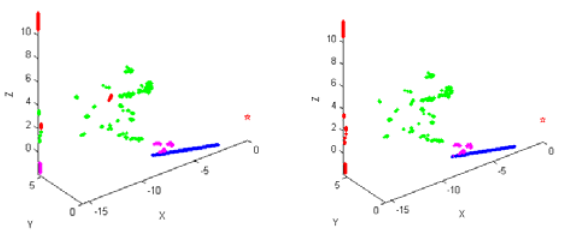
Figure 4. Classification result of the representative scan line obtained from GMM-EM (left) and CRF (right); Red: Vertical objects; Blue: Ground; Green: Tree; Purple: Low object.